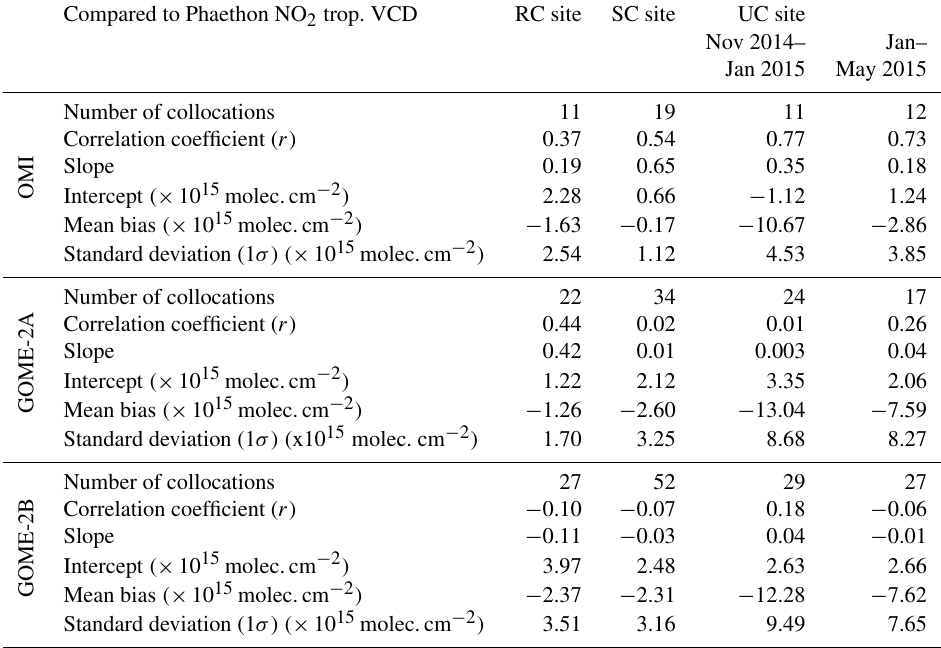
Table 5. Statistics from the comparison of space-borne and ground-based NO 2 tropospheric VCDs for each monitoring site. The same MAX-DOAS data were used as in Table